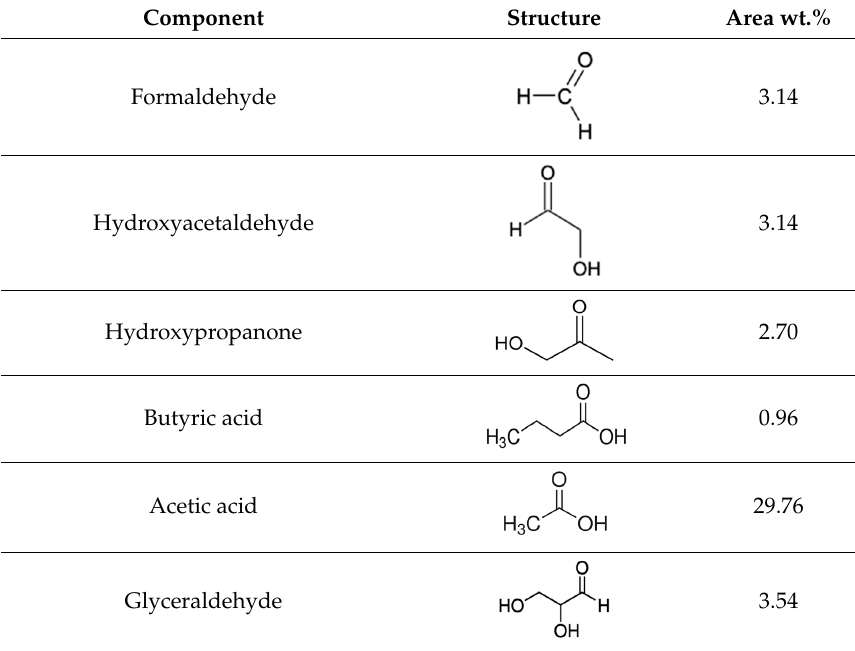
Table 3. Di ff erent oxygenated compounds exist in biomass pyrolysis oil [26]. Table 3. Different oxygenated compounds exist in biomass pyrolysis oil [26]. Table 3. Different oxygenated compounds exist in biomass pyrolysis oil [26]. Table 3. Different oxygenated compounds exist in biomass pyrolysis oil [26]. Table 3. Different oxygenated compounds exist in biomass pyrolysis oil [26]. Table 3. Different oxygenated compounds exist in biomass pyrolysis oil [26]. Component Structure Area wt.% Table 3. Different oxygenated compounds exist in biomass pyrolysis oil Formaldehyde